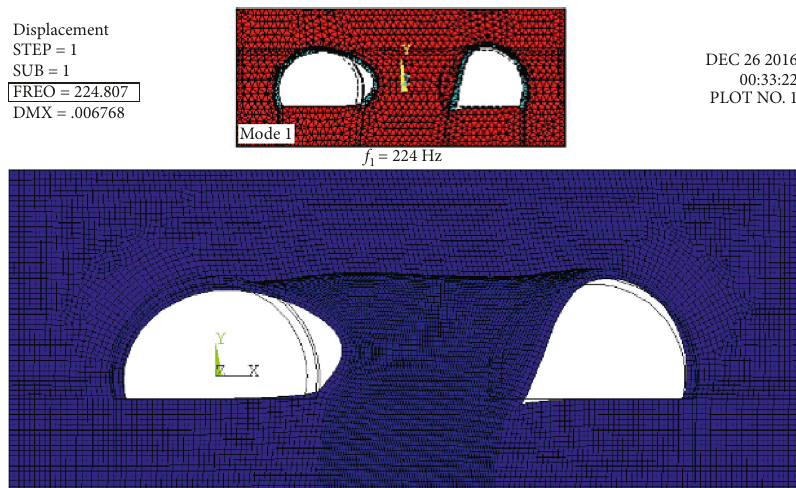
Figure 2: Verification of modal analysis with the study bySevim [37].